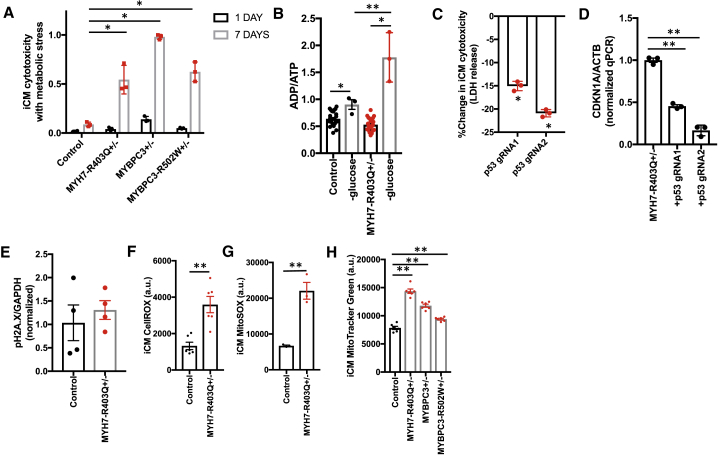
HCM iCMs Exhibit a p53-Dependent Cytotoxicity with Metabolic Stress that Is Related to Increased Oxidative Stress(A) Proportion of iCM death after 1 and 7 days of metabolic stress induced by growth in glucose-free medium.(B) ADP:ATP for iCMs cultured in normal growth medium and after 24 hr in glucose-free medium.(C) Change in iCM cytotoxicity measured by lactate dehydrogenase (LDH) release assay upon p53 genetic knockdown using lentiCRISPR encoding two independent gRNAs that target the TP53 gene.(D) qPCR analysis of CDKN1A normalized to ACTB obtained from cDNA libraries generated from MYH7-R403Q+/– iCMs transduced with lentiCRISPR encoding two independent TP53 or non-targeted gRNAs.(E) Quantification of phosphorylated H2A.X normalized to GAPDH using densitometry analysis of immunoblots from iCM lysates.(F and G) Quantification of fluorescence (arbitrary units) using FACS analysis of iCMs stained with CellROX green (F) or MitoSOX red (G), a mitochondrial-specific probe for reactive oxygen species.(H) Quantification of fluorescence (arbitrary units) using FACS analysis of iCMs stained with MitoTracker green.Significance (∗p < 0.05 and ∗∗p < 0.001) was assessed by ANOVA (A) or Student's t test (B–H); and data are means ± SEM (error bars) (A–H). Each data point represents results obtained from a sample generated from a batch of iCMs (A–H) generated by at least three biological replicates by iPS differentiation batch.